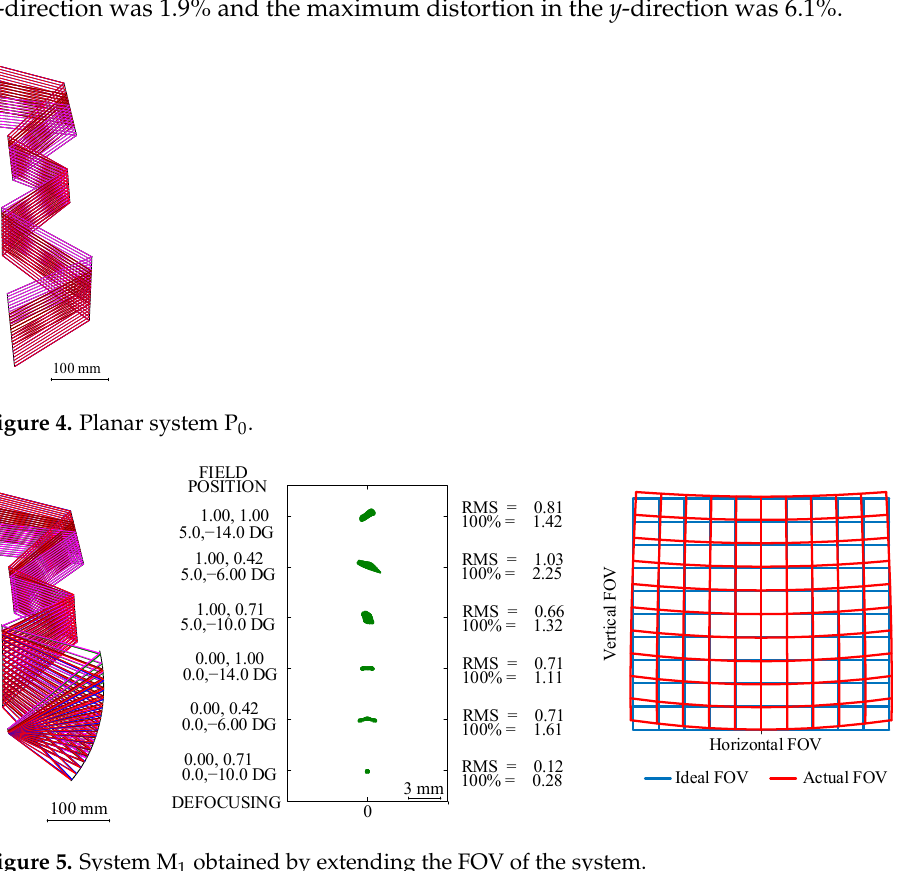
Figure 5. System M 1 obtained by extending the FOV of the system.